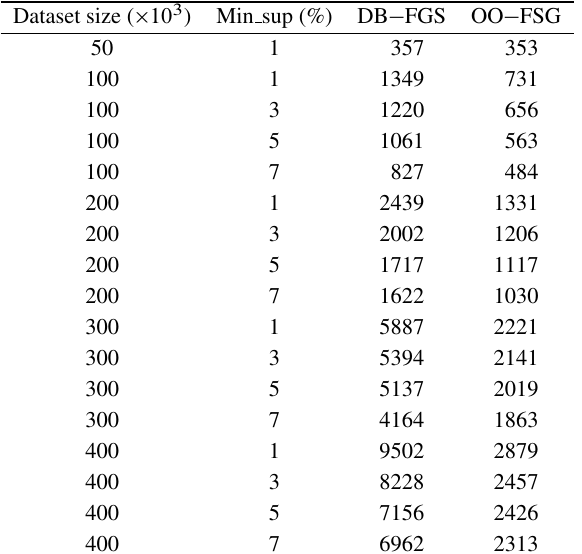
Table 5 Example